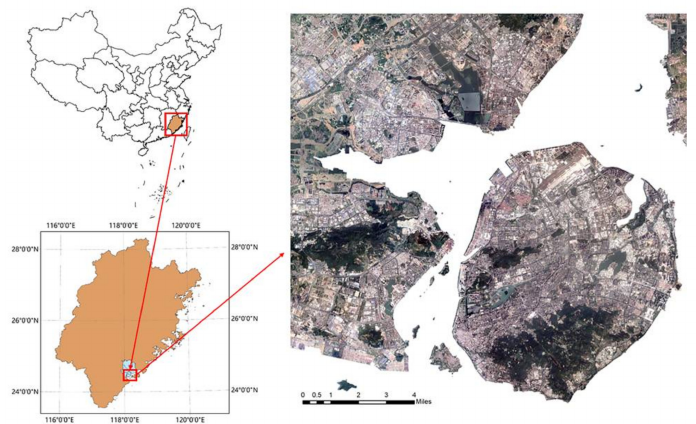
Figure 1. Location of the study